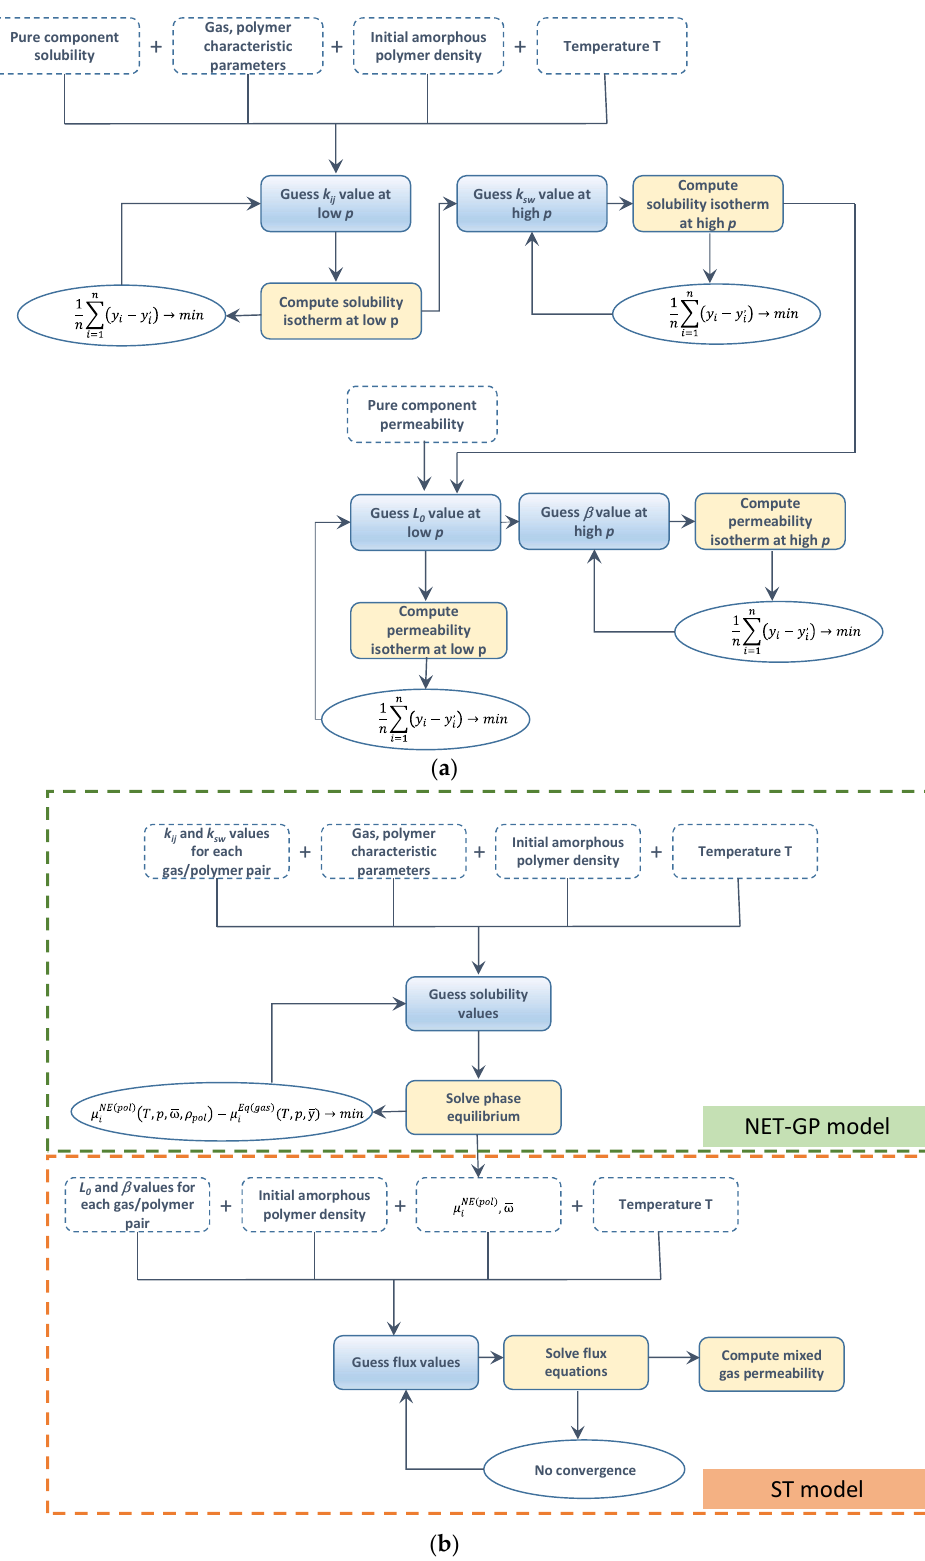
Figure 15. Flowchart of the data inputs (dashed boxes) and the main (colored boxes) and complementary (solid boxes) steps of the ( a ) parametrization and ( b ) mixed-gas transport prediction procedure of the ST model.